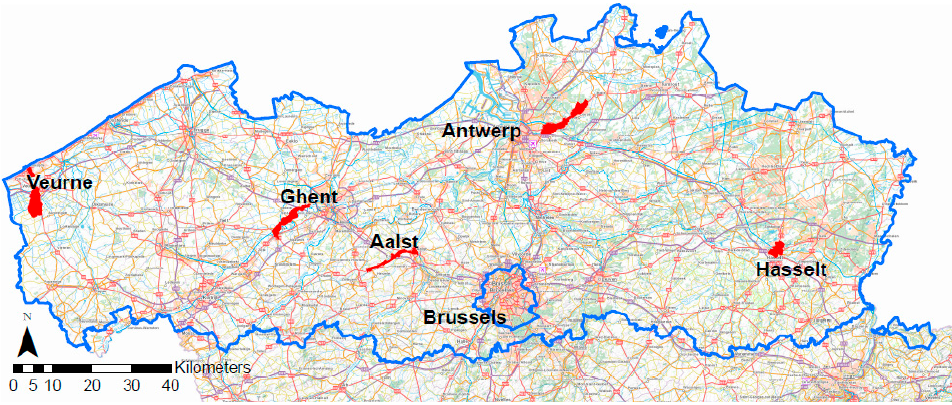
Figure 1. Situation of the five case study areas within Flanders.